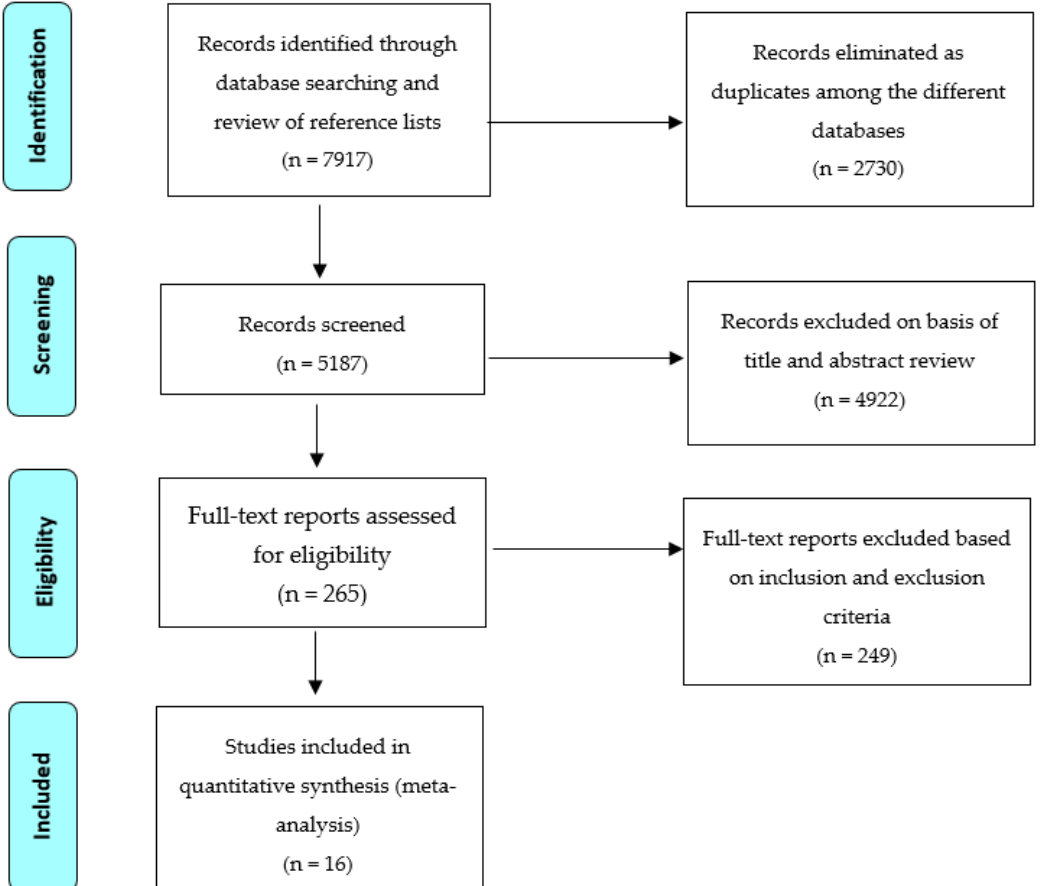
Figure 1. PRISMA flowchart for review and selection of studies in the systematic review.